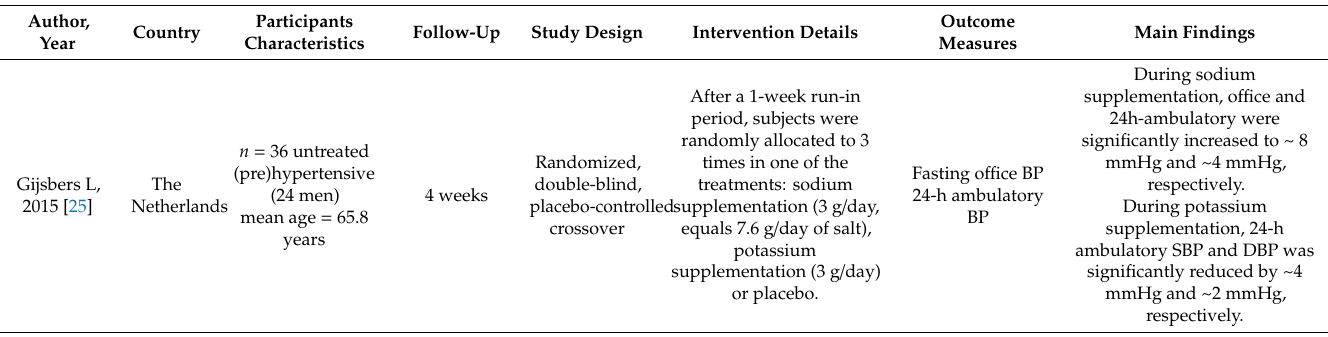
Table 3. Characteristics of included trials in systematic review of dietary sodium, potassium, sodium-to-potassium ratio, and cardiovascular